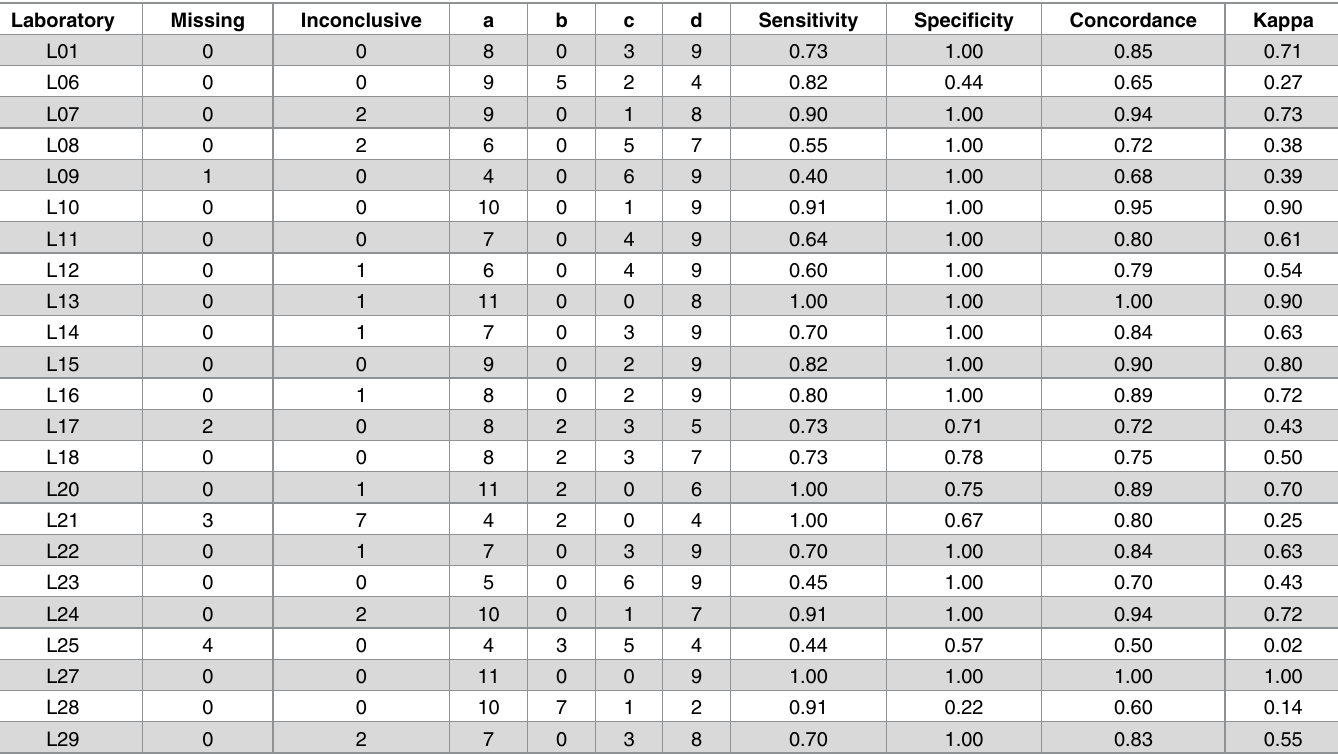
Table 2. Results by Laboratory and agreement relative to CDC expectedresults.